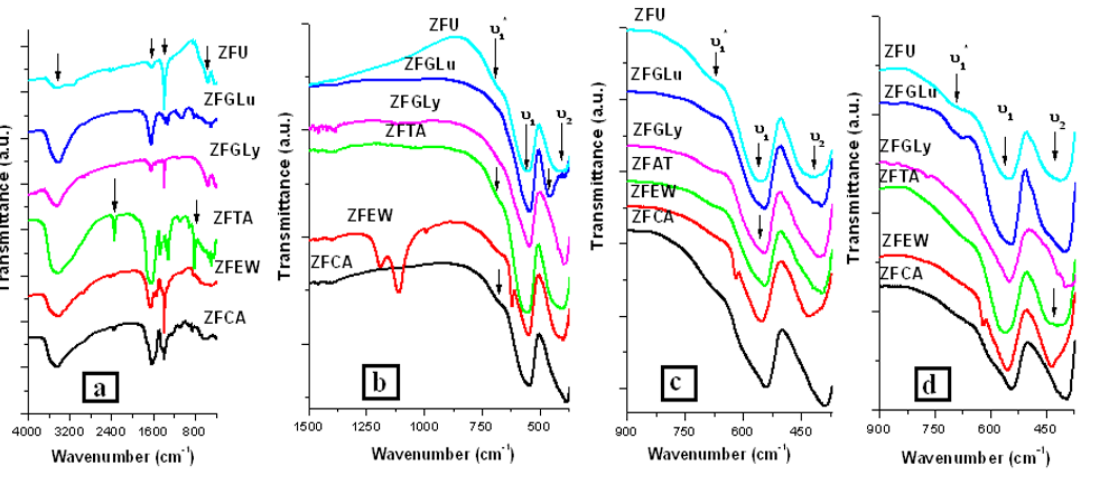
Figure 1. FT-IR data for ZF samples: (a) after heat treatment at 473 K, (b) after heat treatment at 773 K, (c) after heat treatment at 973 K, (d) after heat treatment at 1173